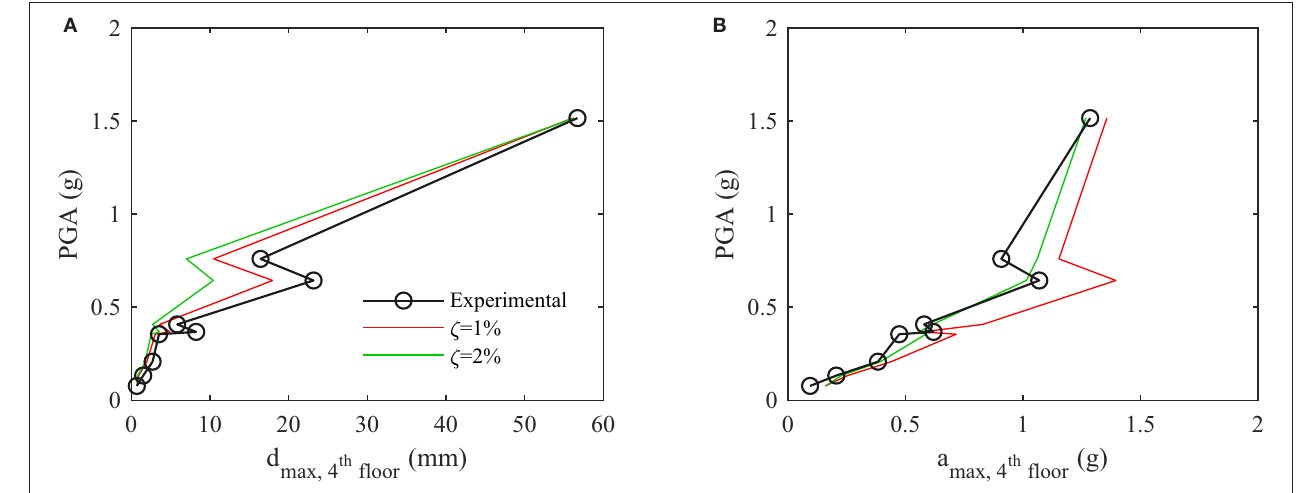
FIGURE 12 | Mixed RC/URM building: global response parameters predicted by the models for different damping ratios. (A) Maximum displacements and (B) maximum acceleration at the top floor.